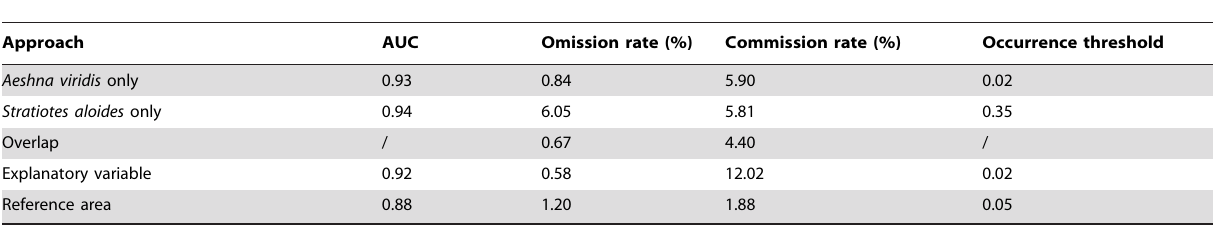
Table 1. Model performance and occurrence thresholds of the applied approaches.